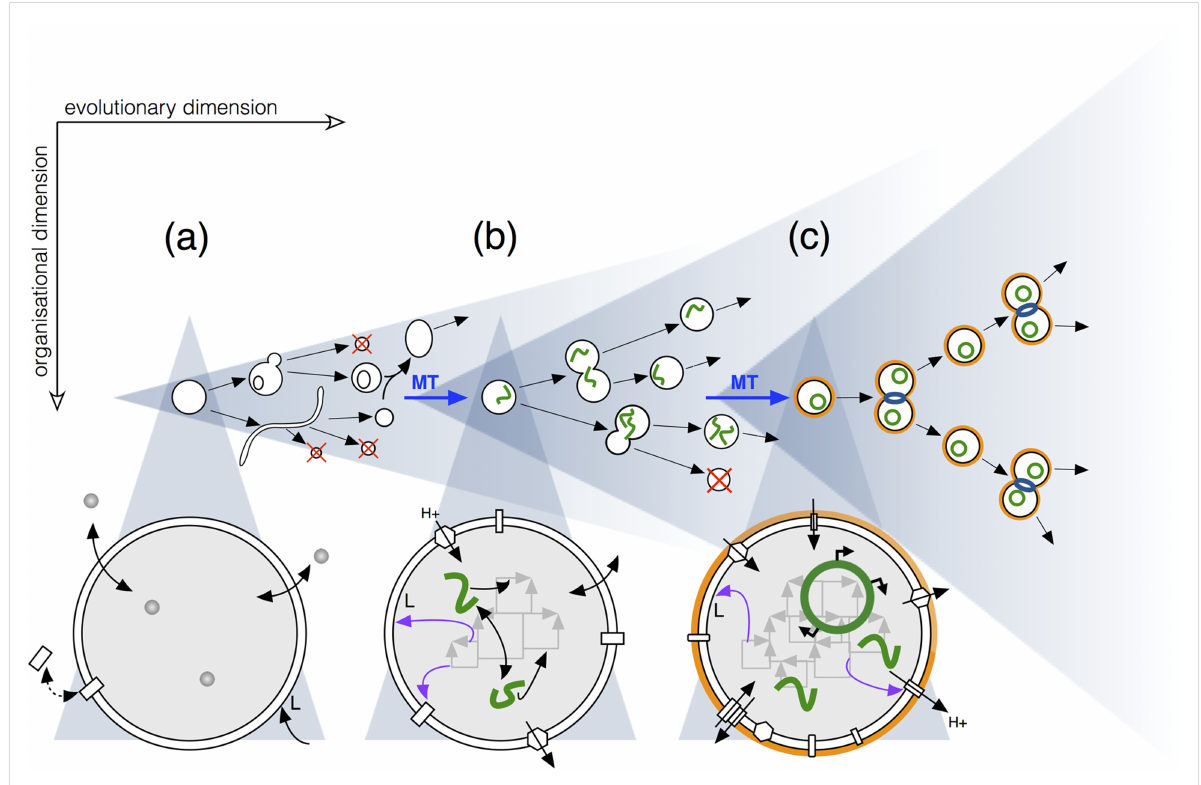
Figure 1: Protocells as the main units of prebiotic evolution: three hypothetical stages of development toward LUCA, with the correlation between protocell organisation and evolutionary potential depicted at each stage. Adapted from [43]. (a) Self-assembled (poly-disperse and likely multilamellar) fatty acid vesicles first start to grow and divide in an unregulated and error-prone way, relying extensively on environmental conditions and external stimuli. (b) After a major prebiotic transition (blue arrow ‘MT’), the first self-producing protocells appeared, able to endogenously synthesise mem- brane lipids and other membrane components. These protocells, hypothetically making use of the first ‘energy transduction mechanisms’ (leading to precursor ‘energy currencies’ – based on thioesters [62] and/or pH gradients [53], for instance) and a metabolism that incorporated oligonucleotides and oligopeptides (to become RNA and proteins only at a later stage), could activate growth and – still not fully reliable – division cycles more inde- pendently of the environment. (c) After a further major prebiotic transition, protocells would reach complexity levels analogous to LUCA’s. Metabolism at that stage already operated on the basis of a ‘genotype–phenotype’ decoupling, with the development of DNA and coding, to enable an open- ended search for new functionalities. The invention of the cell wall and complex protein machinery controlling cell division made reproduction cycles much more coordinated and